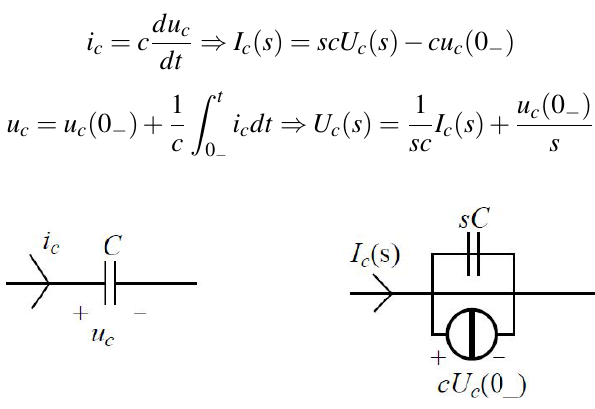
Fig. 2 Capacitance model.